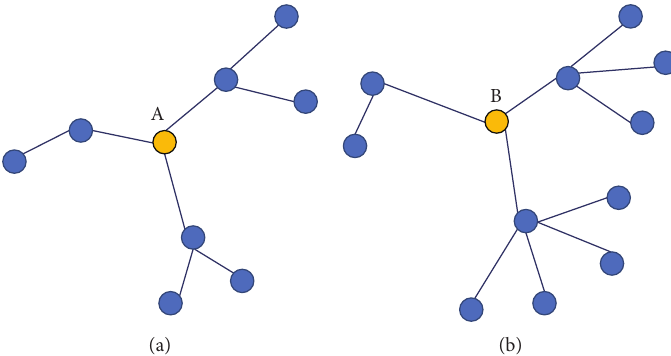
Figure 1: Sketch maps of influence based on the derivation of mapping entropy. As is shown, the degree of node A in subgraph (a) is equal to the degree of node B in subgraph (b). In traditional models, they are considered to have the same influence. Nevertheless, in the DME model, the differences in the contribution of their neighbors are taken into account. We think that node B has more influence. By calculation, we quantify the influence of A and B as 3 . 77 , 4 ,